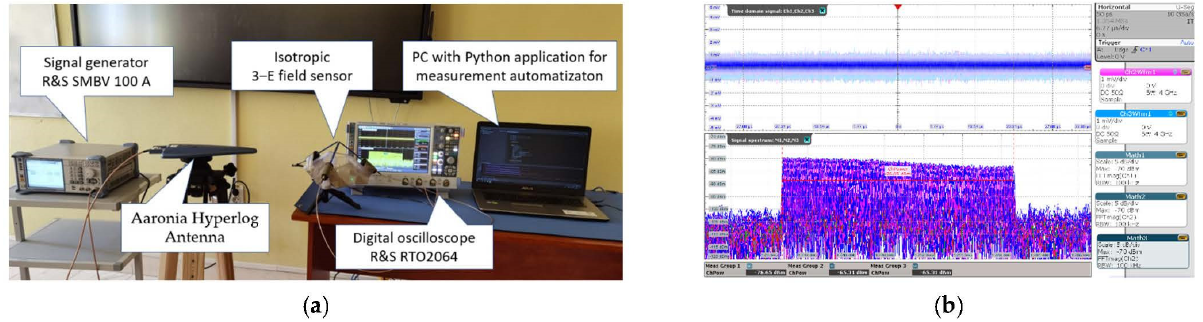
Figure 7. ( a ) DO-enabled measurement system, ( b ) DO screen during a measurement activity.